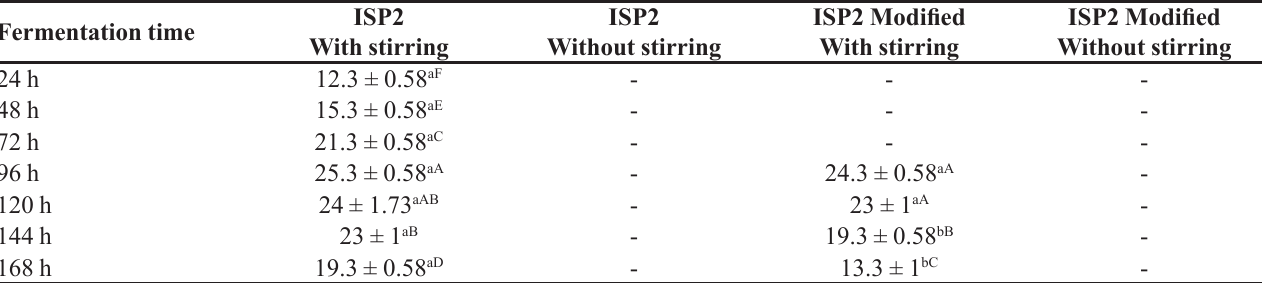
TABLE I - Mean values of halos of inhibition of Candida albicans growth compared to the different liquid fermented Fermentation time